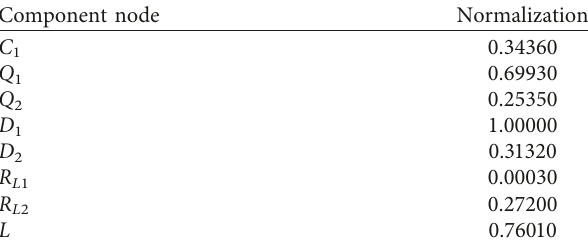
Table 2: Normalization of the comprehensive importance of each component of the power conversion main